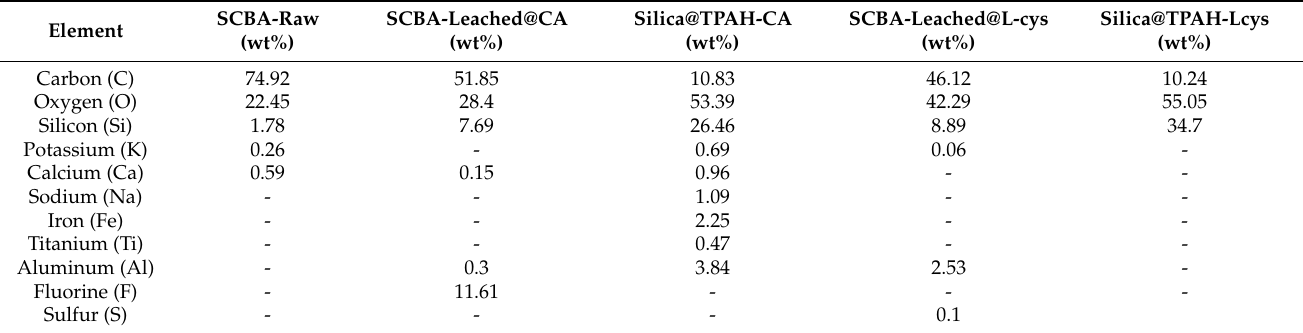
Table 1. Chemical analysis of sugarcane bagasse composition acid treated with citric acid (ca) and L-cysteine hydrochloride monohydrate